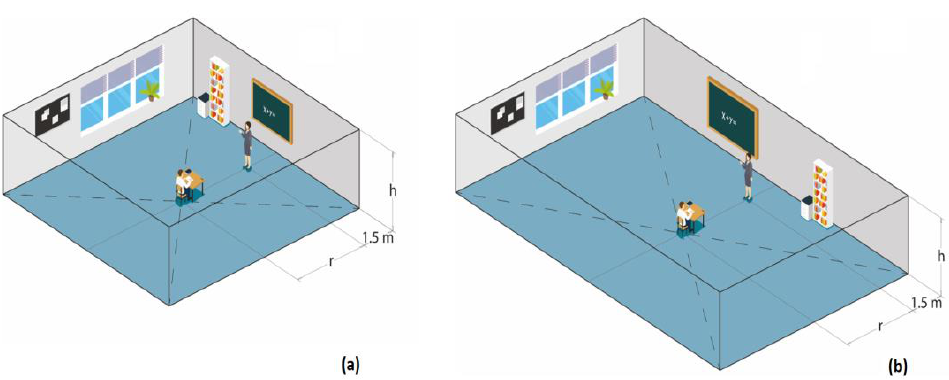
Figure 1. Axonometric diagram of the assumed arrangement of the location of the source and the receiver within a: ( a ) Square-shaped classroom; ( b ) Rectangular-shaped classroom. Plausible 𝑟 ranges can be easily found (Figure 2).